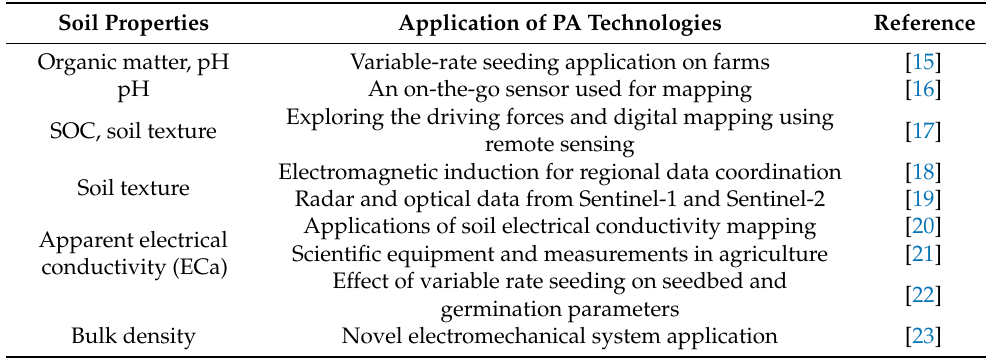
Table 1. The main soil properties applicable to PA